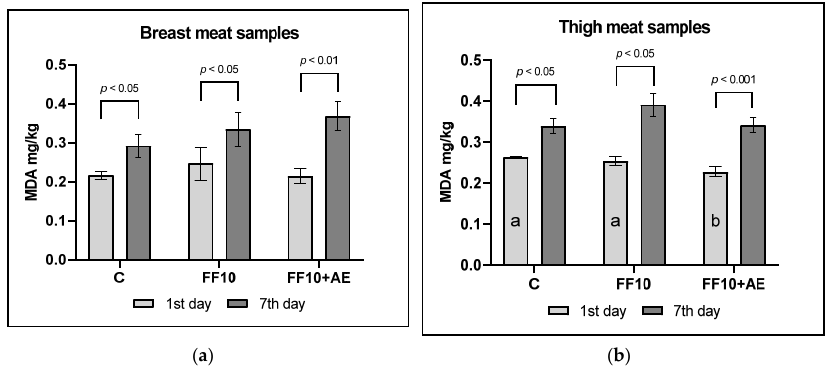
Figure 1. ( a ) The results of malondialdehyde (MDA) content in breast meat samples during storage at 4 ± 2 °C (mg/kg means ± SD). ( b ) The results of malondialdehyde content in thigh meat samples during storage at 4 ± 2 °C (mg/kg means ± SD). C: control group; FF10: broilers fed with a diet enriched with supplementation of 10% FF; FF10 + AE: broilers fed with a diet enriched with 10% supplementation of FF supported with 0.2% agrimony extract a, b Means in bars with a different superscript letter are statistically different (Tukey’s test, p < 0.05). The results of the breast and thigh meat fatty acid profiles are shown in Table 7. The supplementation of 10% of SSF, as well as a combination of 10% SFF and AE, show a significant impact on the fatty acid profiles of the fat composition of breast meat. The increase in GLA content in breast meat samples for both experimental groups was significant ( p < 0.001). Table 7. Fatty acid profile of breast and thigh meat samples (means ± SD).